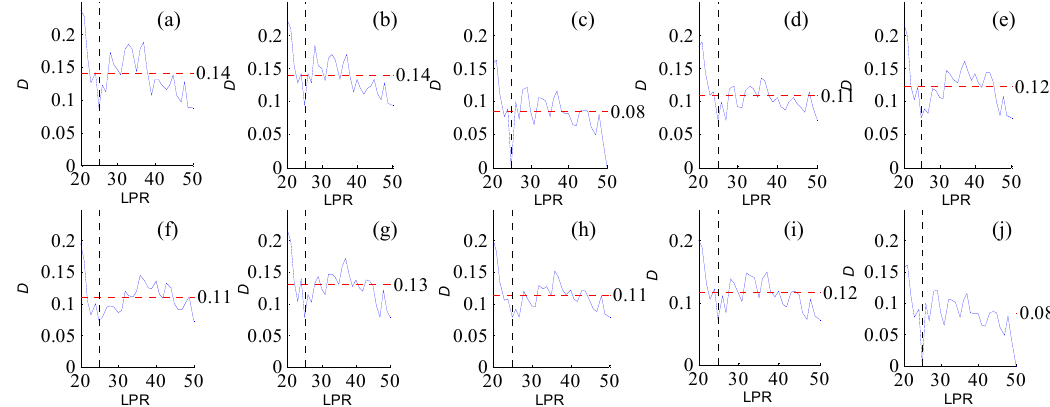
Figure A1. Variation of flow regime alteration degree (D) measured by the RVA with change in the length of pre-impact flow time series (LPR) under a periodicity of 25 years. ( a ), ( b ), ( c ), ( d ), ( e ), ( f ), ( g ), ( h ), ( i ), and ( j ) correspond to post-impact flow time series length = 18, 21, 25, 29, 32, 36, 39, 43, 46, and 50 years, respectively. The abscissa value for the vertical dotted line is 25. The ordinate value for the horizontal dotted line is the mean degree of flow regime alteration in each subfigure.